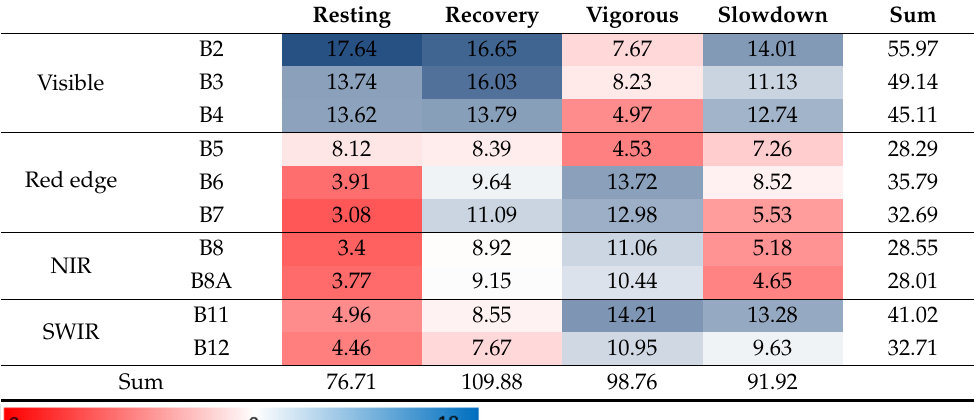
Table 5. Feature importance for S2 bands and rubber tree phenological